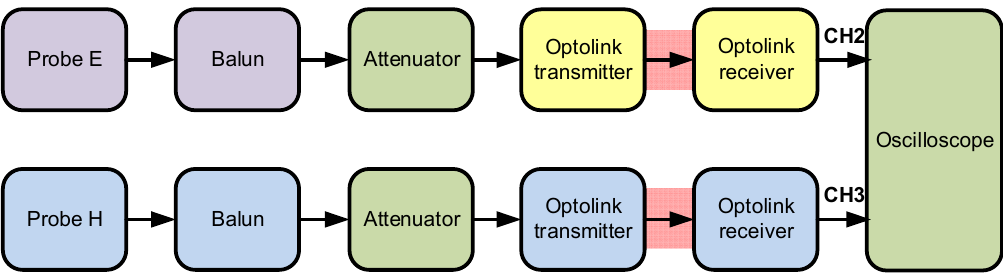
Figure 12. Measurement setup for the electric E and magnetic H fields. Probe E—Montena SGE3-5G; Probe H—Montena SGM2G; Balun—Montena BL3-5G; Optolink-Montena MOL3000 + FCLB100; Attenuator—Montena attenuators: 10, 20, 30 dB; Oscilloscope—LeCroy Waverunner 940Zi. Field measurements with the HPM generator were made at distances of 10, 20 and 30 m from the signal source (parabolic antenna). Each time a set of a dozen or so sinusoidal packets was registered and the first of them was rejected due to its unspecified nature, which stems from the properties of the generator itself (Figure 13).